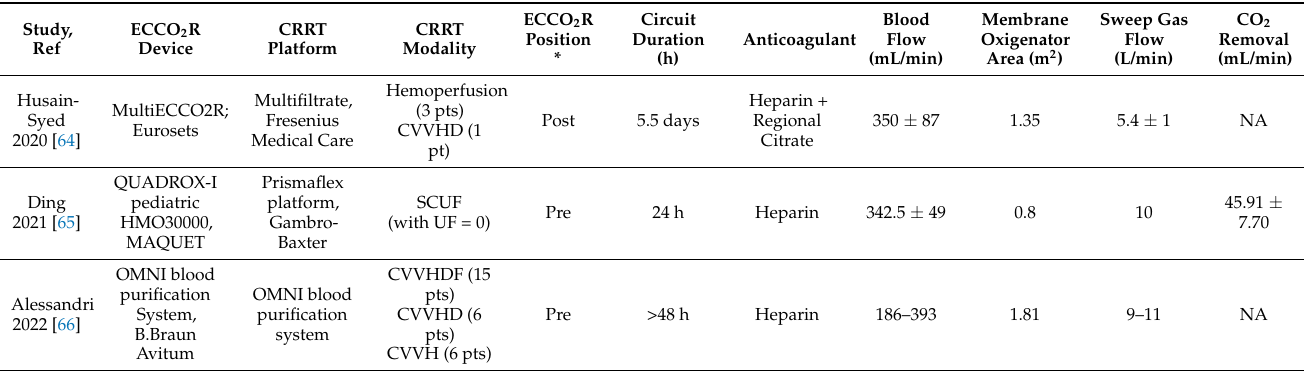
Table 4. Devices and operative parameters of studies reporting use of combined ECCO 2 R–CRRT treatment in COVID-19 patients with